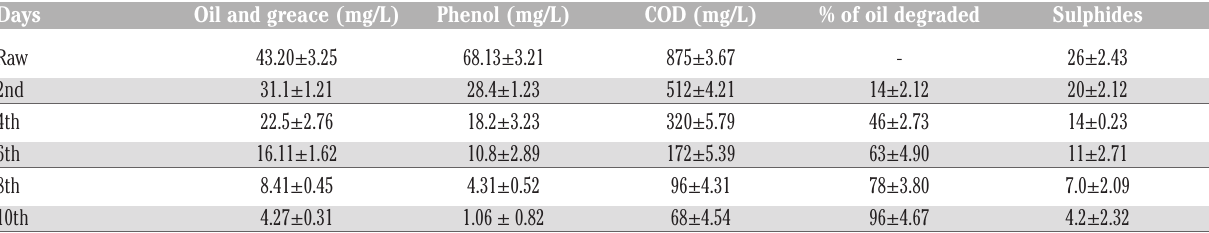
Table 2. Bioremediation of refinery wastewater using transconjugant.